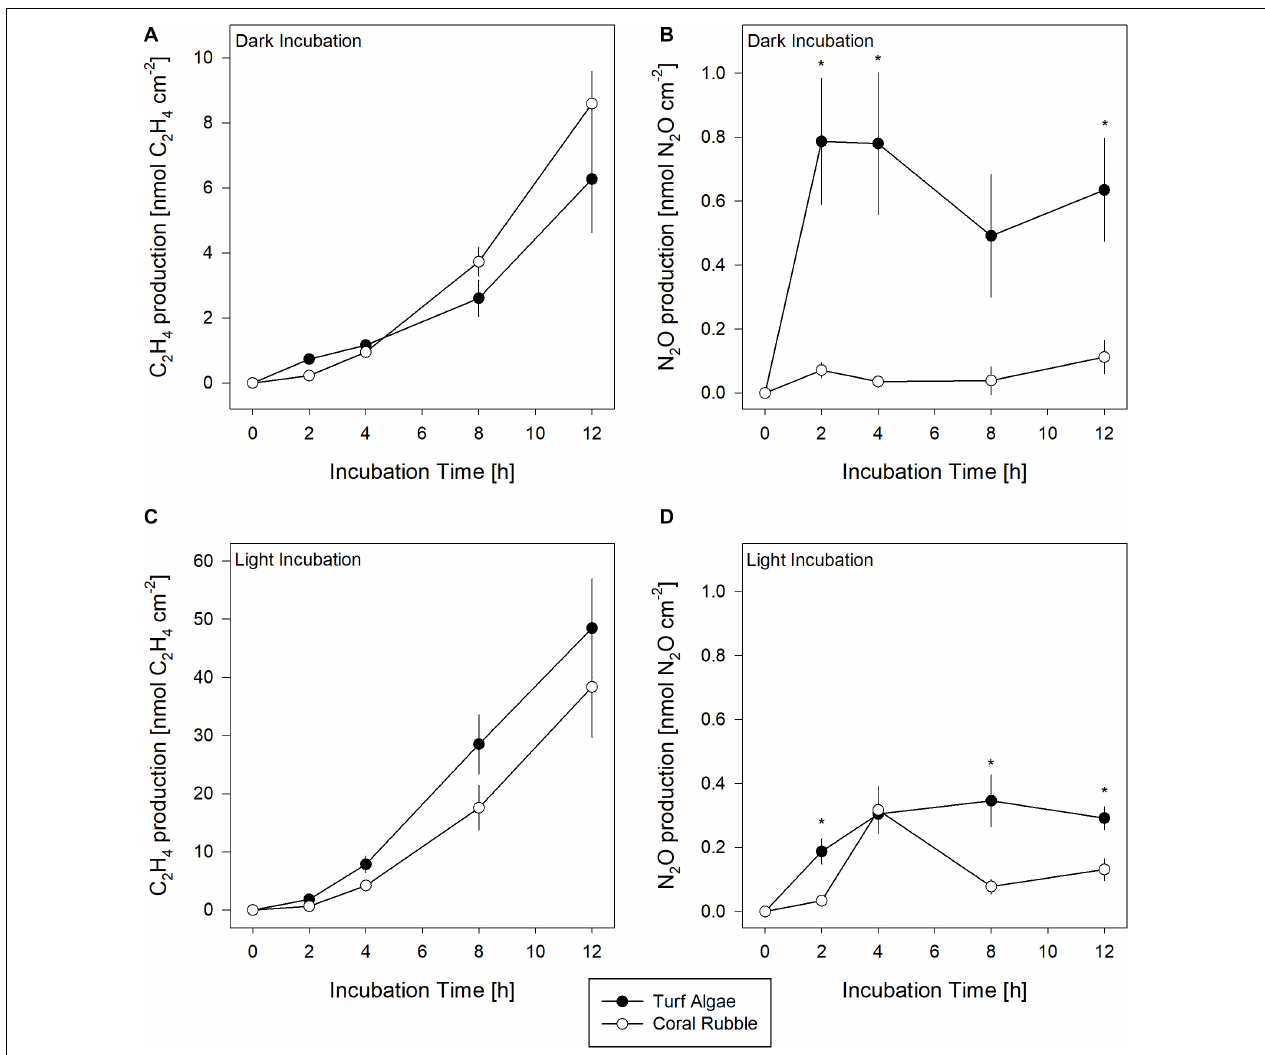
FIGURE 2 | Ethylene (C 2 H 4 ) production as a proxy for N 2 -fixation (A,C) and nitrous oxide (N 2 O) production as a proxy for denitrification (B,D) in turf algae ( n = 5) and coral rubble ( n = 4) in dark (top graphs) and light (bottom graphs) incubation over time. Asterisks indicate significant differences ( p < 0.05) between both substrates. Note: Different scales for C 2 H 4